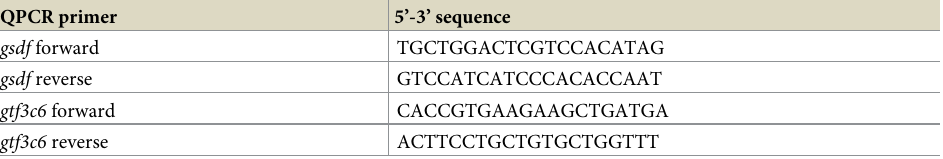
Table 2. Primers used for